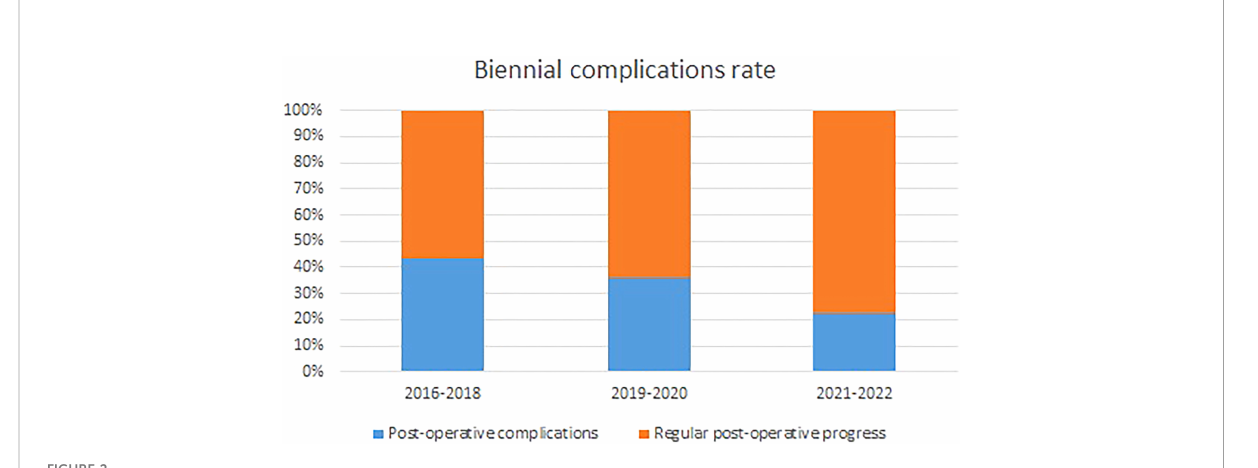
FIGURE 2 Distribution of the postoperative complications according the biennium.